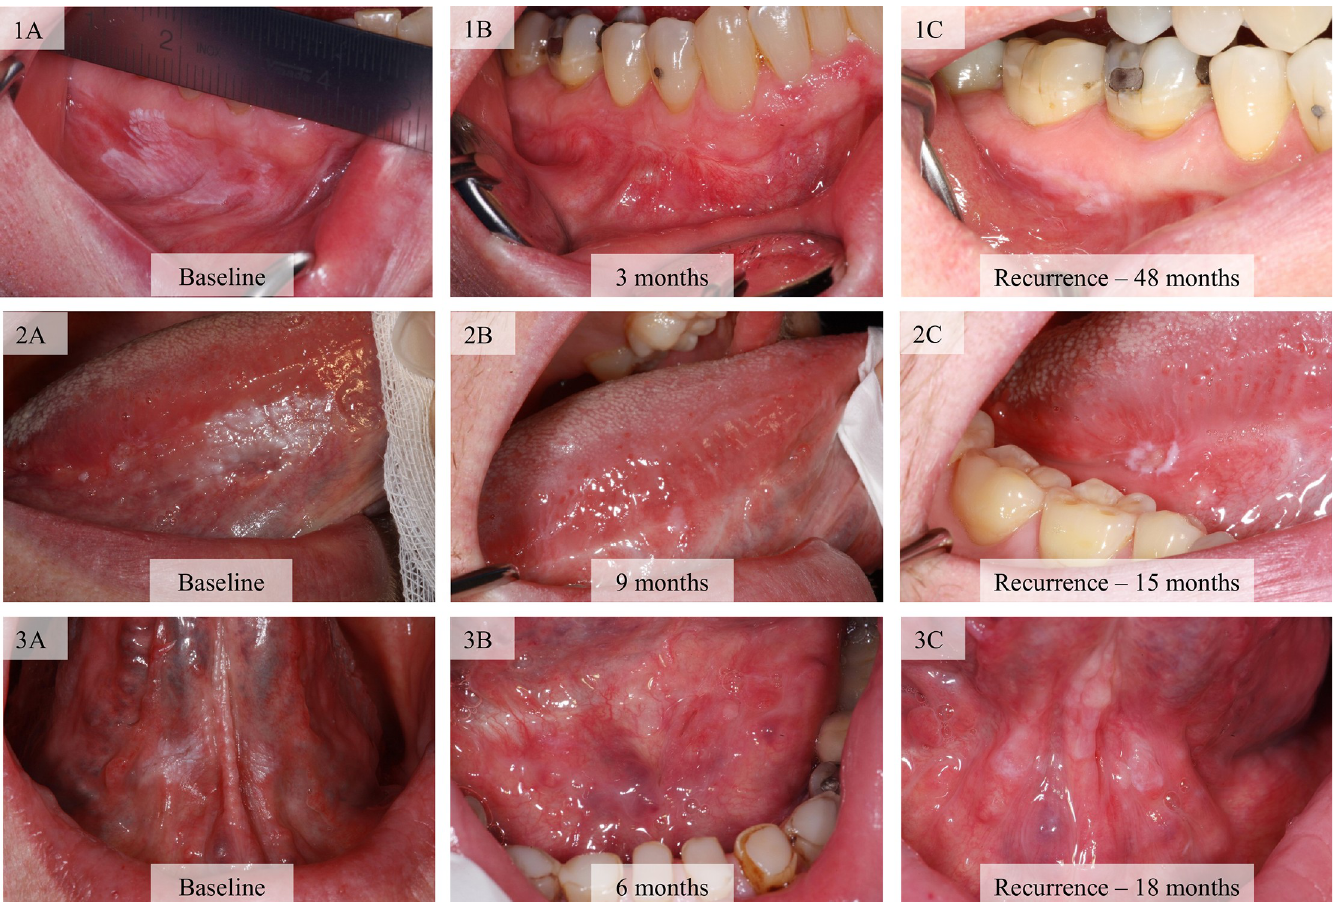
Fig 3. Clinical appearances of three patients and the definition of a recurrence of leukoplakia. Patient 1: A, B, C; 2: A, B, C; 3: A, B, C. A clinical healthy mucosa had to be recorded with a clinical photograph between the time of surgery and the time of recurrence.